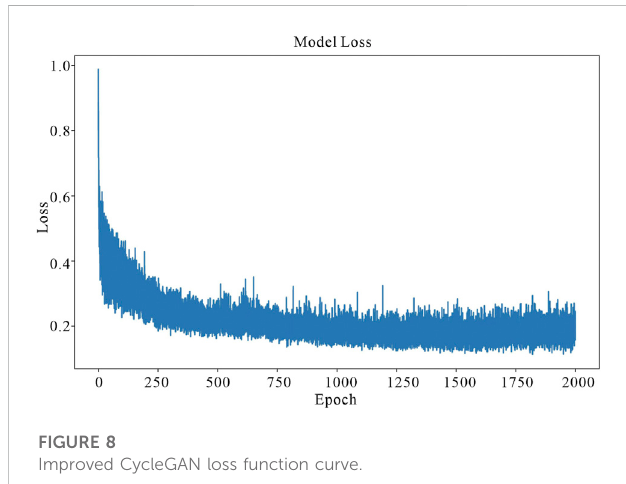
FIGURE 8 Improved CycleGAN loss function curve.